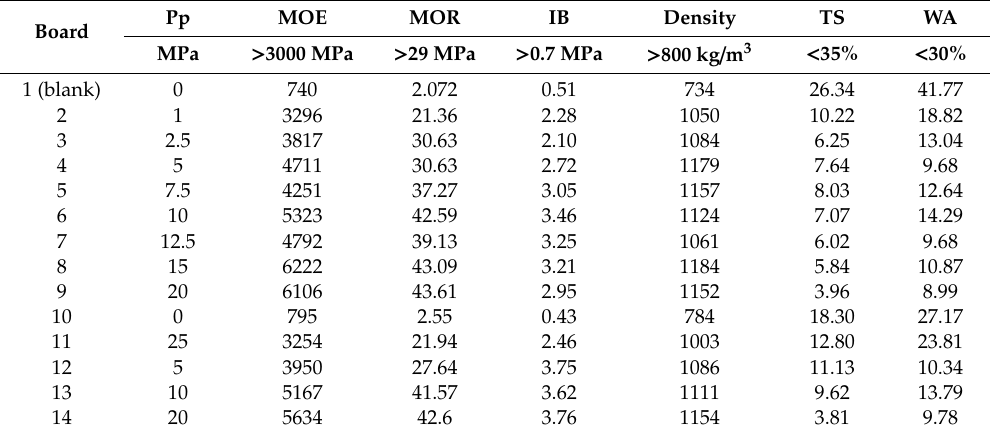
Table 4. Results for series 22.